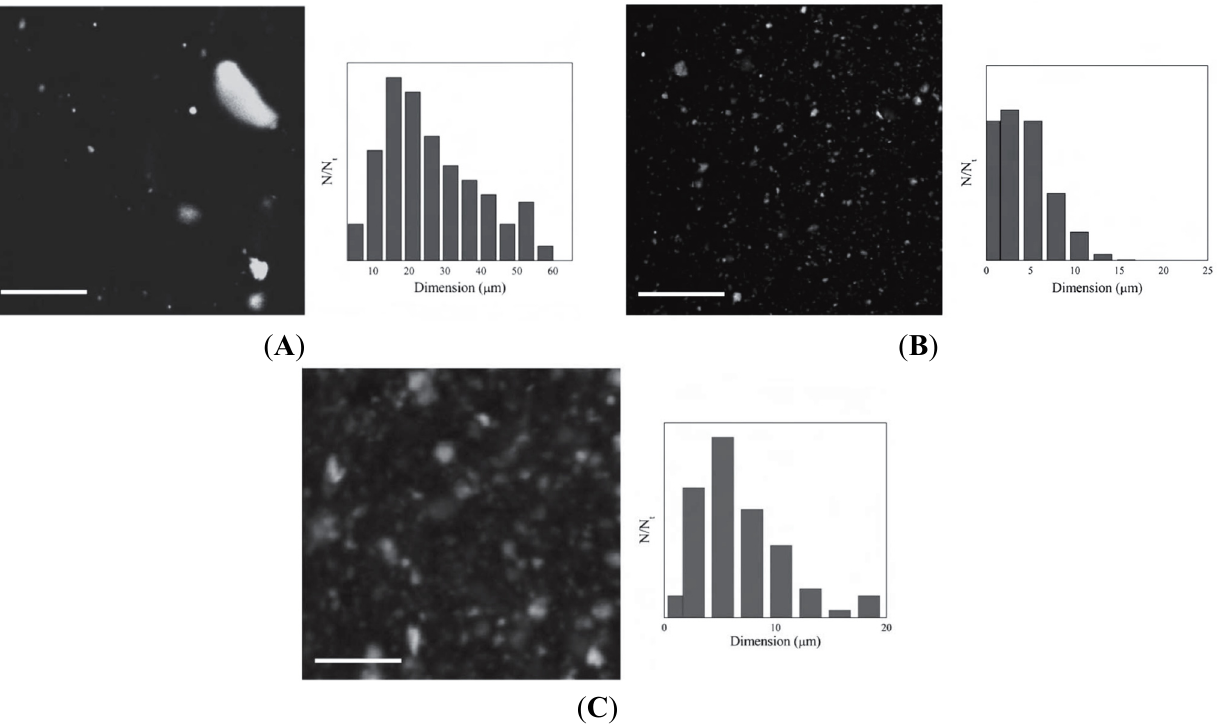
Figure 5. Fluorescence confocal images of polypropylene (PP)/CloNa–R6G ( A ); PP/Clo20A–R6G ( B ) and PP/Clo30B–R6G ( C ). Scale bar corresponds to 100 μ m.